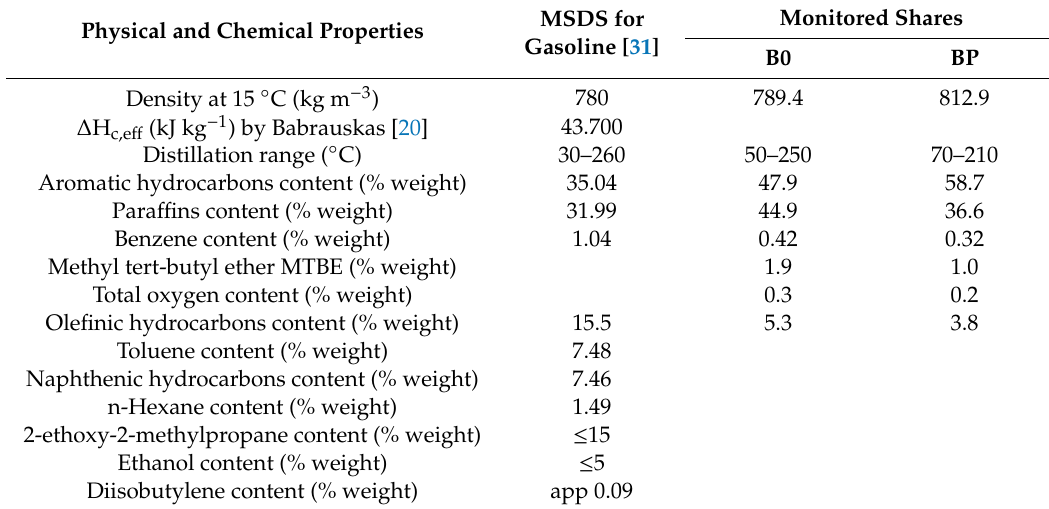
Table 3. Physical and chemical properties of investigated Gasoline (MSDS of gasoline [31]) and comparison of selected shares in B0 and BP and in gasoline